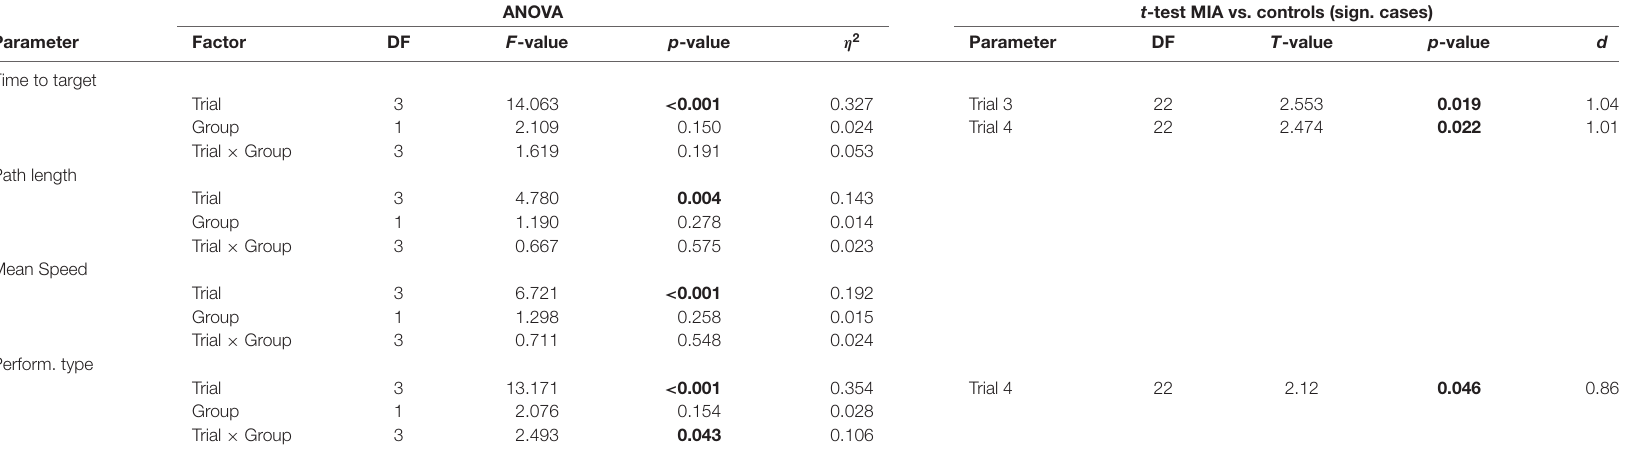
TABLE 3 | ANOVA and post hoc t -test results of the analysis of MWM data in case of iTBS applied to adult rats, using factors Group (MIA, controls) and trials (1–4). ANOVA t -test MIA vs. controls (sign. cases)